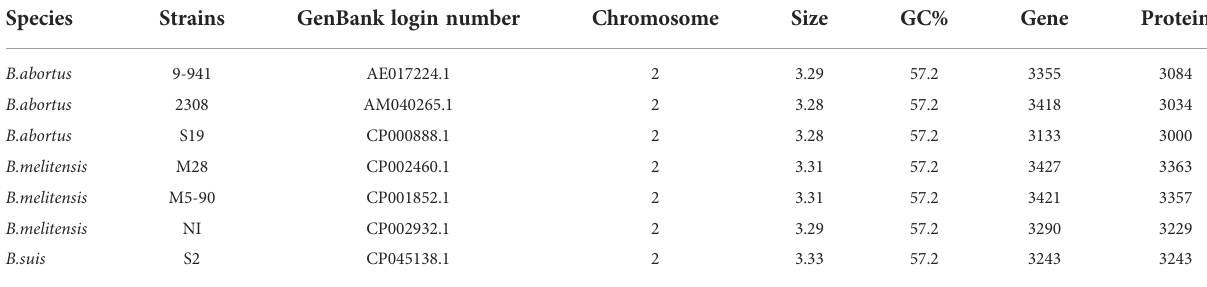
TABLE 1 The basic information of Brucella